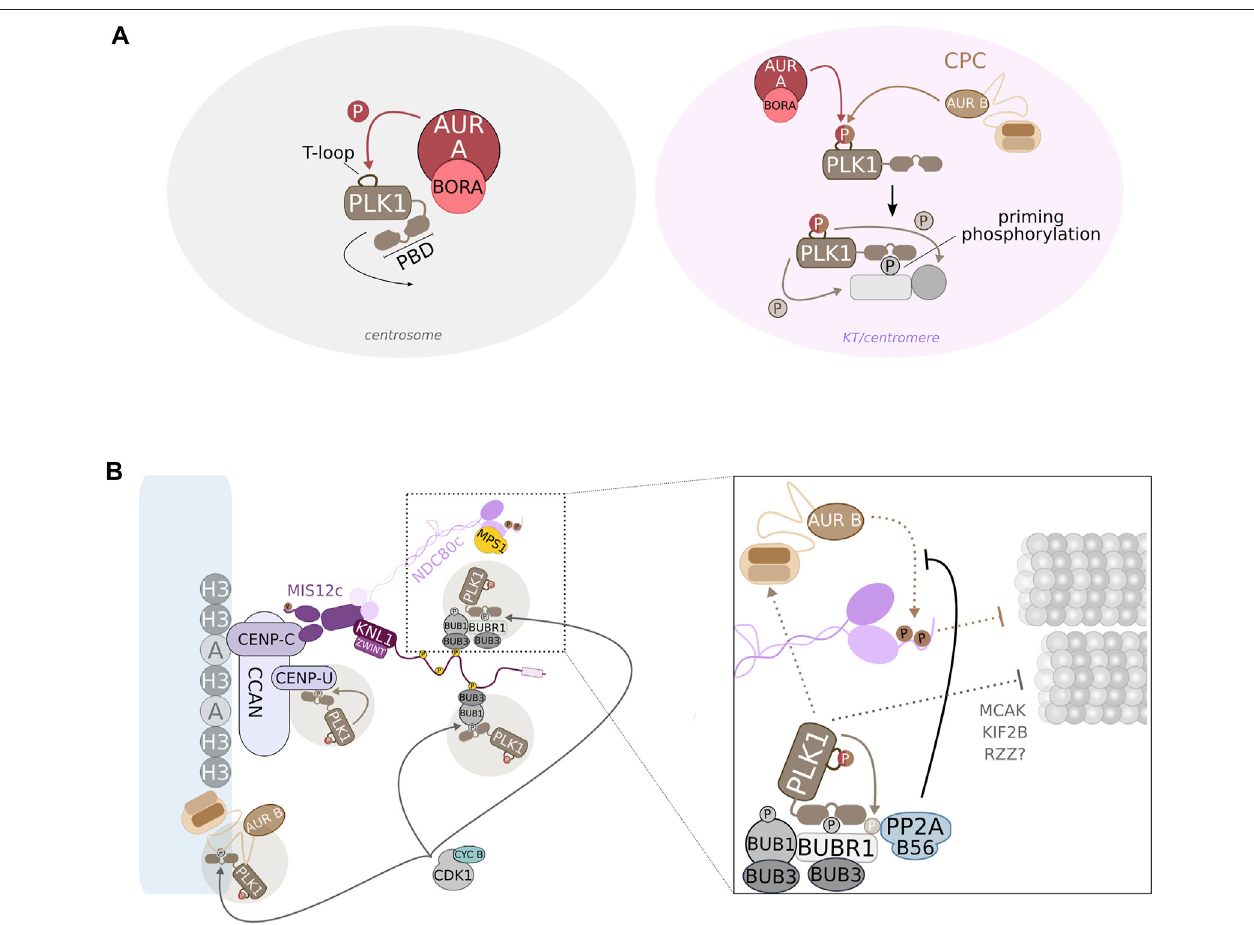
FIGURE 4 | POLO/PLK1 controls the turnover of KT-MT attachments. (A) At late G 2 , AURORA A:BORA phosphorylates PLK1 on its N-terminal T-loop to activate the kinase. At this stage, activation of PLK1 by AURORA A:BORA occurs at centrosomes, but subsequent maintenance of PLK1 activity at centromeres/KTs is likely maintained by AURORA B (although a residual fraction of AURORA A:BORA at KTs may also promoting PLK1 activation). Phosphorylation of the T-loop in PLK1 probably relieves an intramolecular interaction that mutually inhibits the N-terminal kinase domain and the C-terminal PBD. This can potentially contribute to fully activatePLK1byexposingthekinasedomainandallowingthePBDtointeractwithpre-phosphorylated(primingphosphorylation)substrates/bindingpartners. (B) PLK1 is recruited to multiple locations along the centromere/KT axis. CDK1:CYC B-mediated priming phosphorylation of PLK1 binding partners provides a positional cue for the localization of PLK1. However, PLK1 can promote its own recruitment by self-priming (ex, CENP-U/PBIP1). At KTs, PLK1 regulates the turnover of KT-MT interactions by promoting both the stabilization — PLK1-dependent phosphorylation of BUBR1 triggers the recruitment of PP2A:B56 phosphatase that, in turn, counteracts AURORA B activity — and destabilization of attachments — PLK1-dependent phosphorylation of KIF2B and MCAK likely promote MT depolymerization. PLK1 may also promote the destabilization of KT-MT attachments through an RZZ-dependent mechanism.